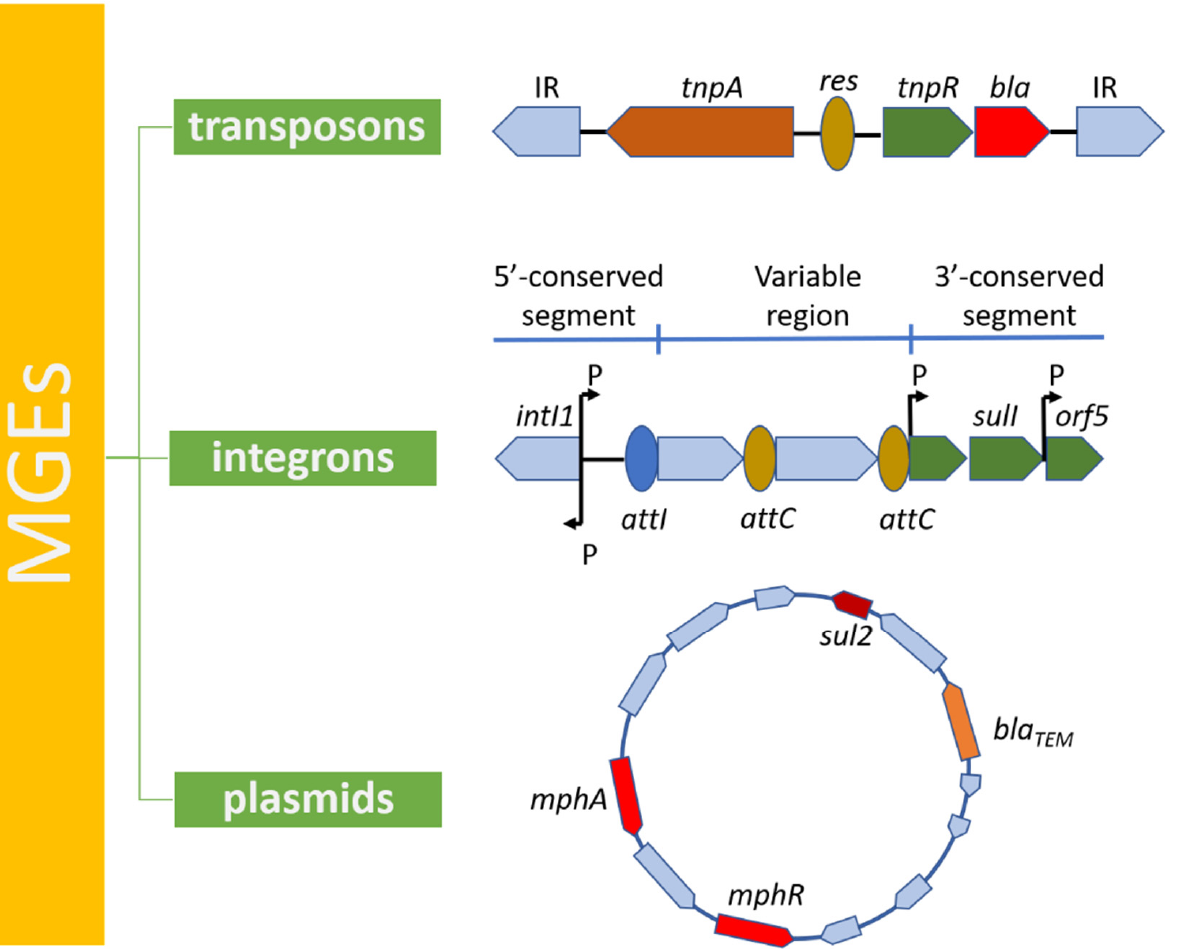
Figure 4. Mobile Genetic Elements (MGEs): transposons, integrons and plasmids are the leading drivers in spreading antimicrobial resistance in many bacteria.